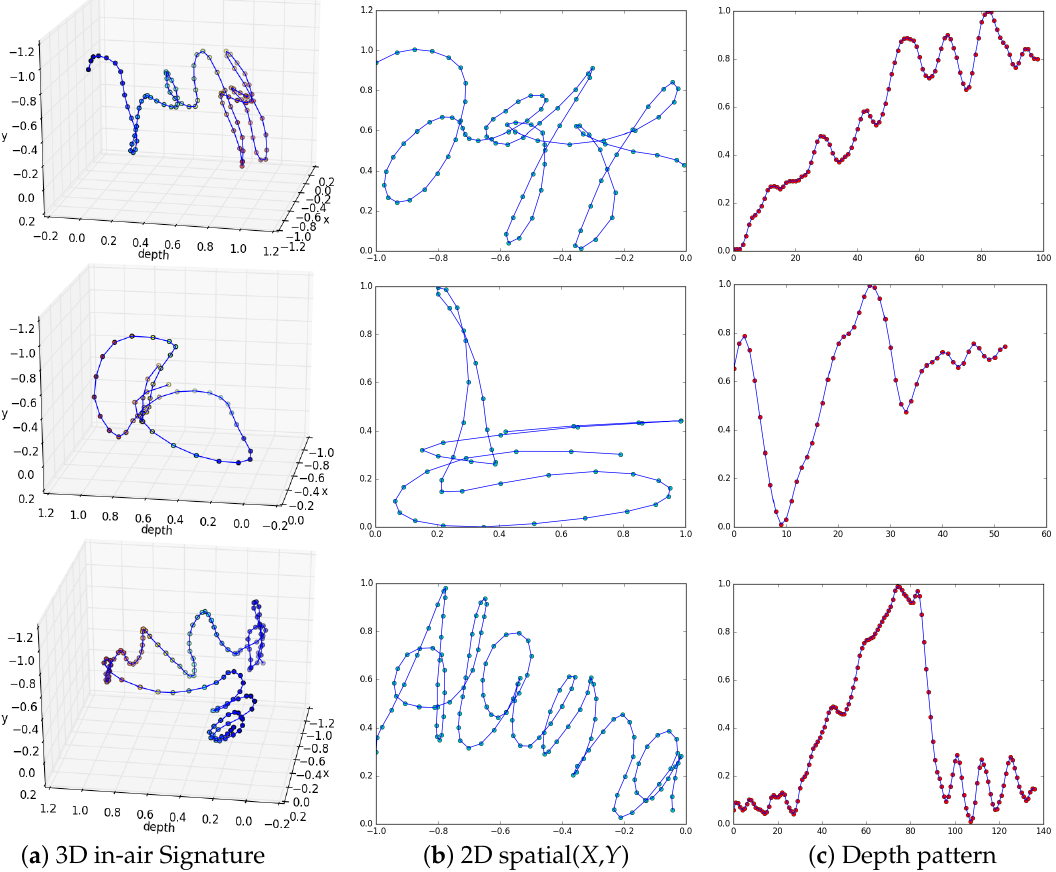
Figure 4. Samples of genuine in-air signatures from our dataset. Each one of the rows shows ( a ) the 3D in-air signature trajectory, ( b ) the 2D spatial view, and ( c ) depth pattern. The depth pattern of each signature is particularly unique and, therefore, it is an important hidden